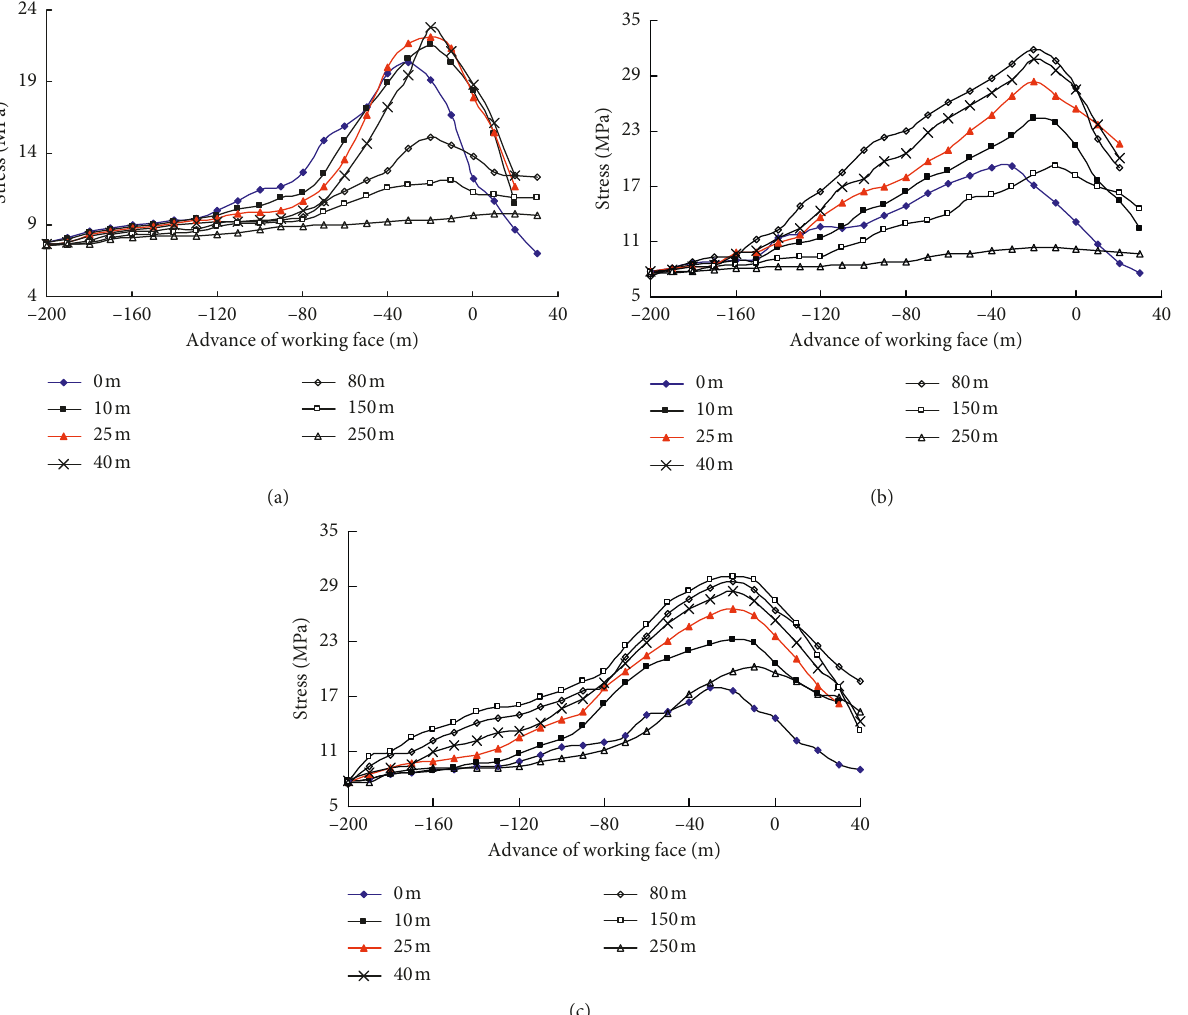
Figure 8: Stress variation curves with different layers of overlying strata in different coal thicknesses with advance of working faces. (a) 9.0 m; (b) 15.0 m; (c)